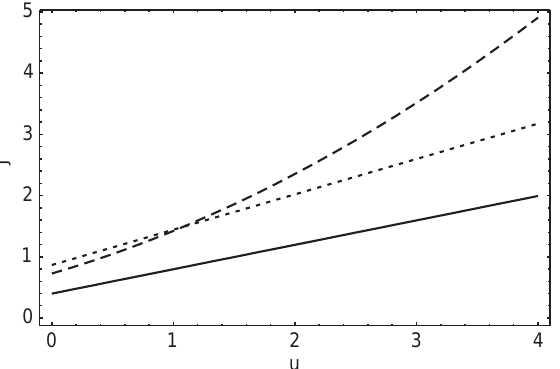
Fig. 9. Comparison of current-voltage relationships in kinetic theory ( solid ; Eq. 38), fluid theory with c (cid:136) 3 ( dotted ; Eq. 56) and fluid theory with c (cid:136) 5 = 3 ( dashed ;